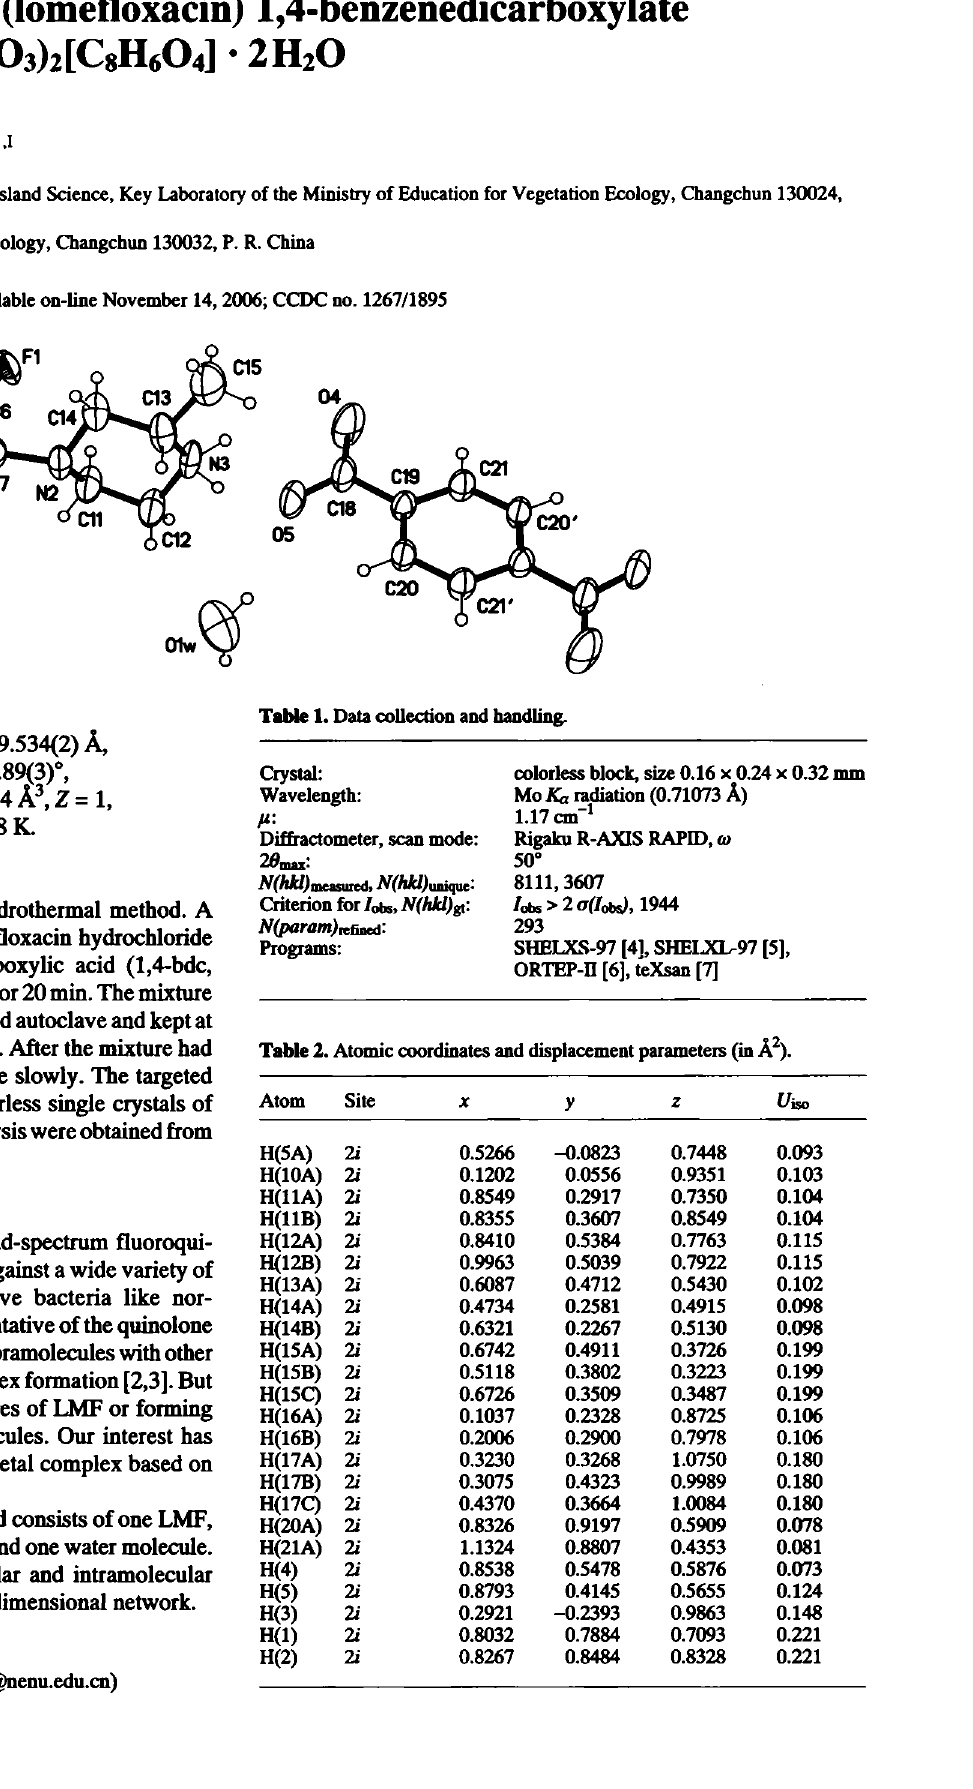
Table 1. Data collection and handling.